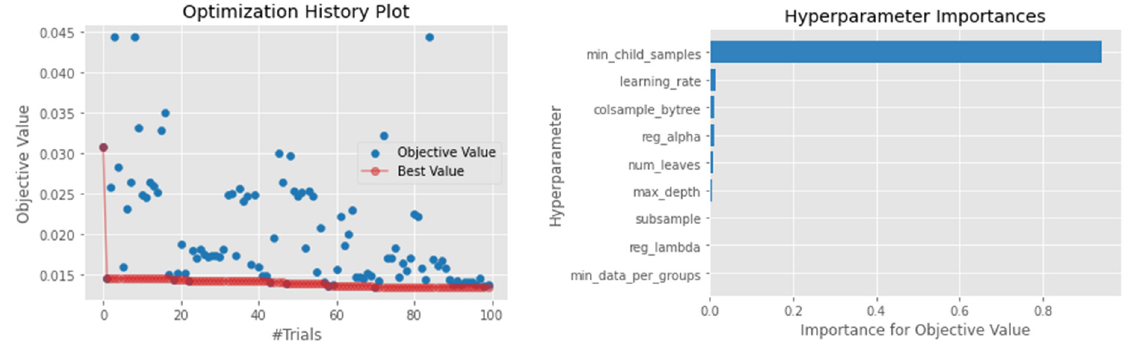
Figure 4. Hyperparameter optimization for the XGBoosting model.